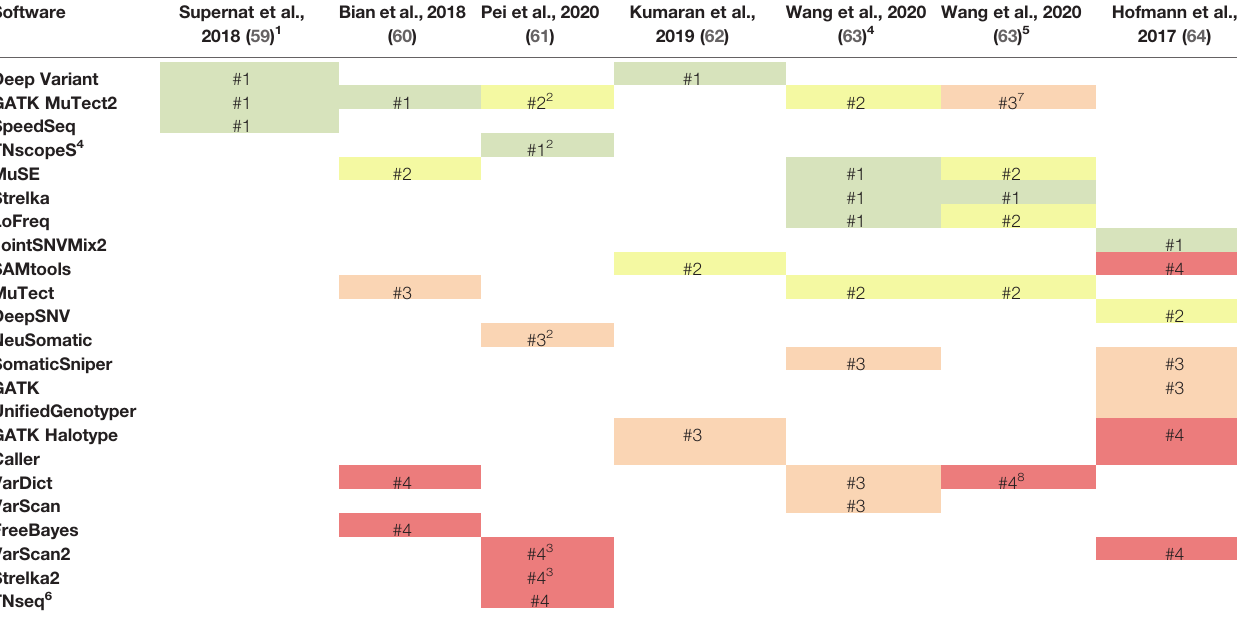
TABLE 1 | Comparison of the ranking of single nucleotide variant (SNV) callers across six benchmarking studies that have been released since 2017.